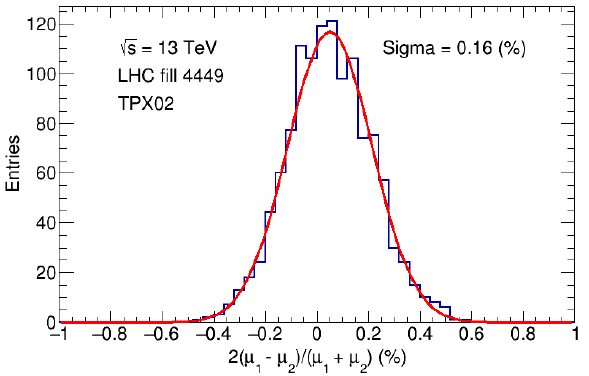
Figure 42. Gaussian fit of the relative difference between the average number of interactions per bunch crossing measured by layers 1 and 2 of TPX02 and TPX12 as a function of time. The data are shown for 10 frames (1s each) combined in order to decrease the statistical uncertainty. LHC fill 4449. Taken from Ref. [14].